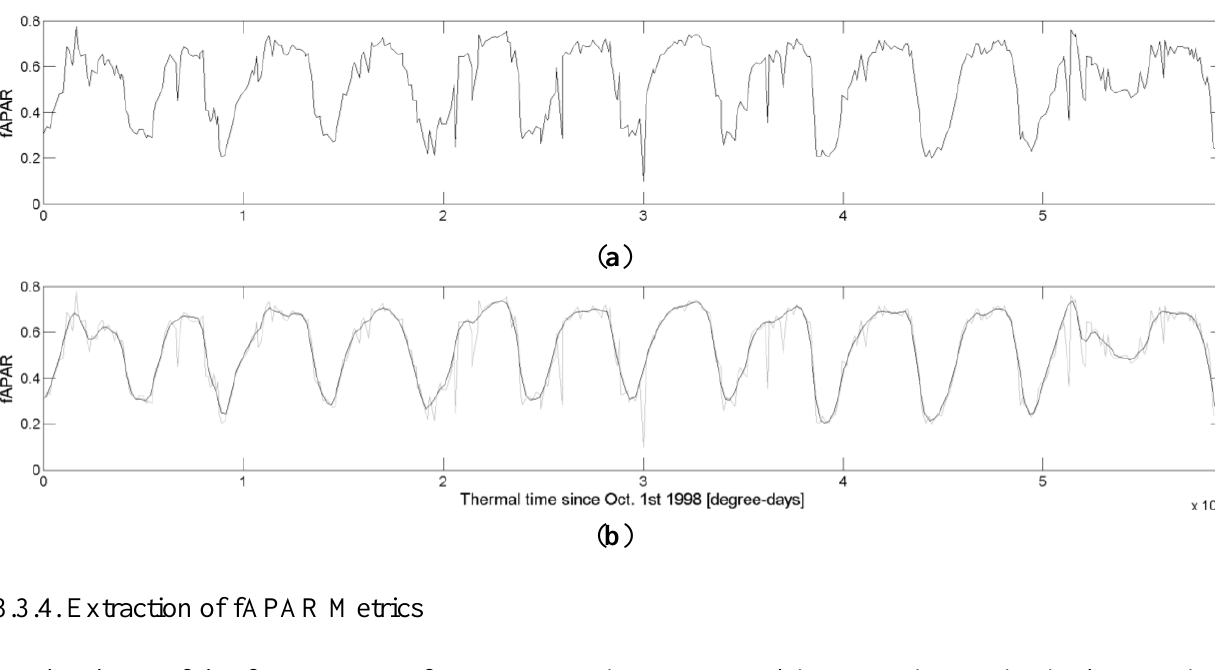
Figure 3. Initial unfiltered and unsmoothed fAPAR data ( a ) and smoothed time series ( b ) in thermal time for a single grid cell.